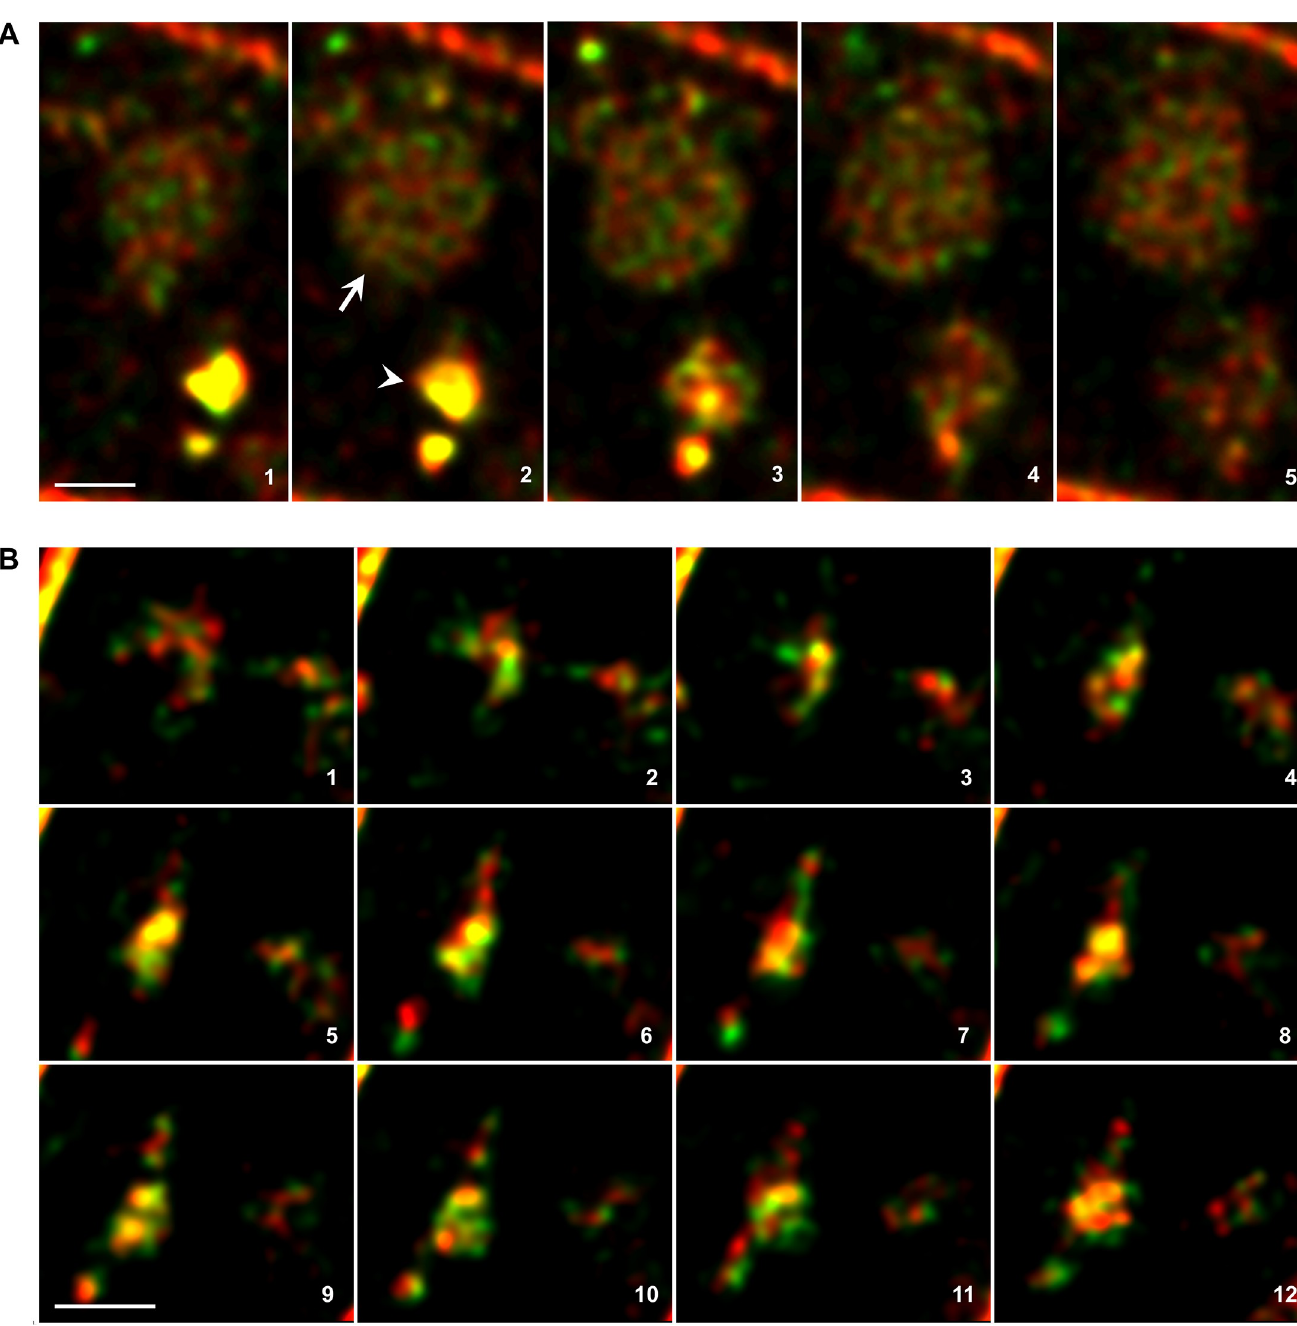
PLOS ONE | https://doi.org/10.1371/journal.pone.0237448 August 13,